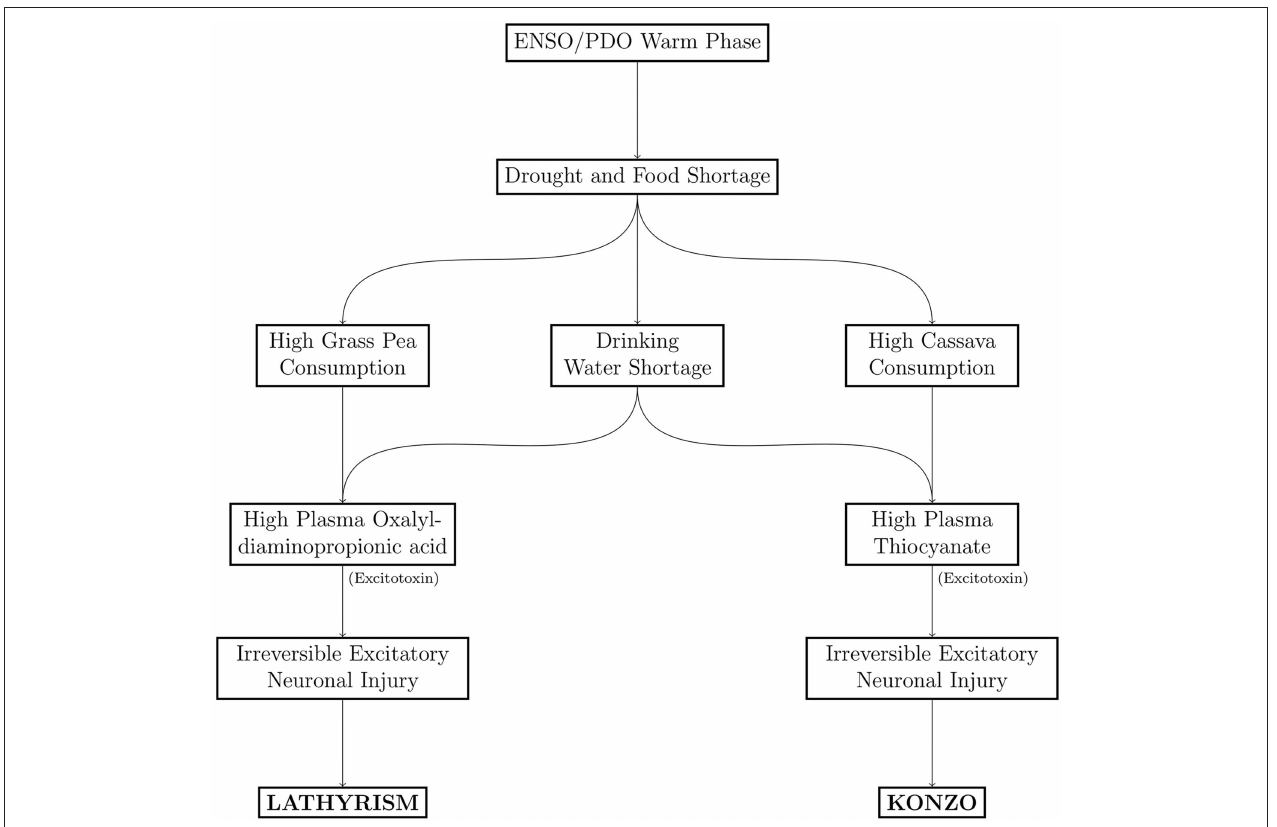
FIGURE 8 | Model of causation of lathyrism and